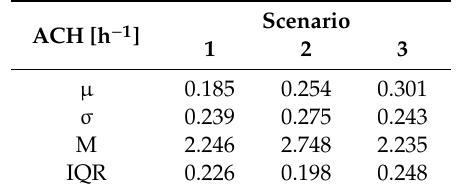
Table 8. Statistical data on the ACH each of the three modeled scenarios.